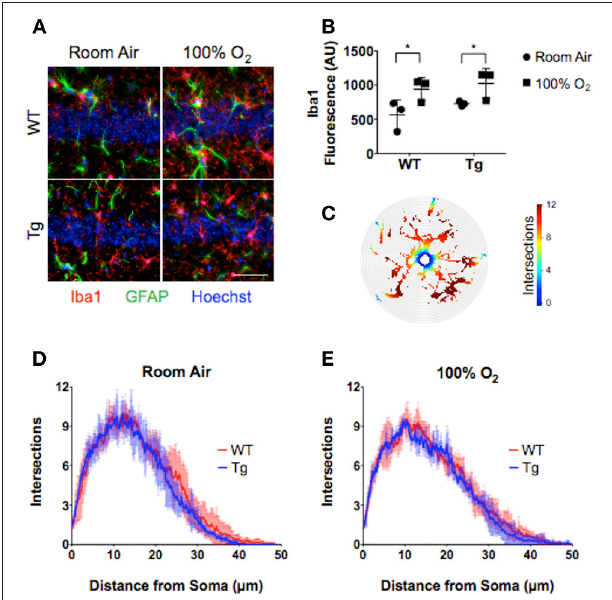
FIGURE 4 | Over-expression of EC-SOD in the lung does not block hyperoxia-induced microglial priming in CA1 of the adult hippocampus. (A) CA1 field of the hippocampus showing neuronal nuclei, Iba1 + microglia, and GFAP + astrocytes. Scale bar = 200 µ m. (B) Neonatal hyperoxia stimulates Iba1 expression in both WT and EC-SOD mice; * P < 0.05. (C) Sholl analysis heat map of microglial processes illustrating the number of intersections with concentric circles from the soma to most distal branch. (D,E) Sholl analyses demonstrating no differences in microglial arborization in either adult WT or Sftpc EC − SOD transgenic mice exposed to room air or neonatal hyperoxia. ( n = 4–5 mice per group except panel B where n = 3 mice per group). Data from individual mice are represented as circle (room air) or squares (hyperoxia) in (B)